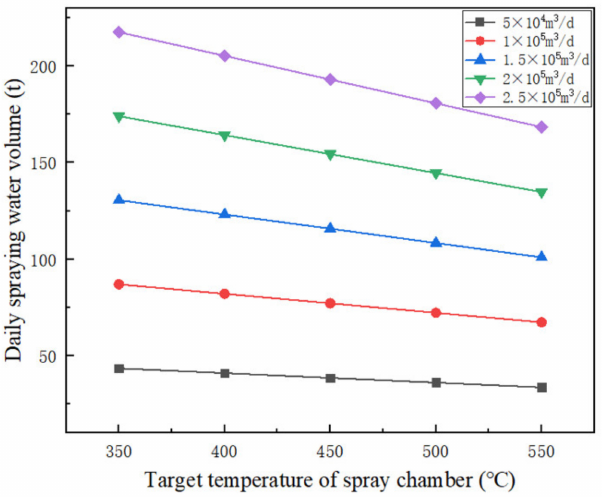
Figure 7. Relationship between spray water volume and target temperature under different levels of gas